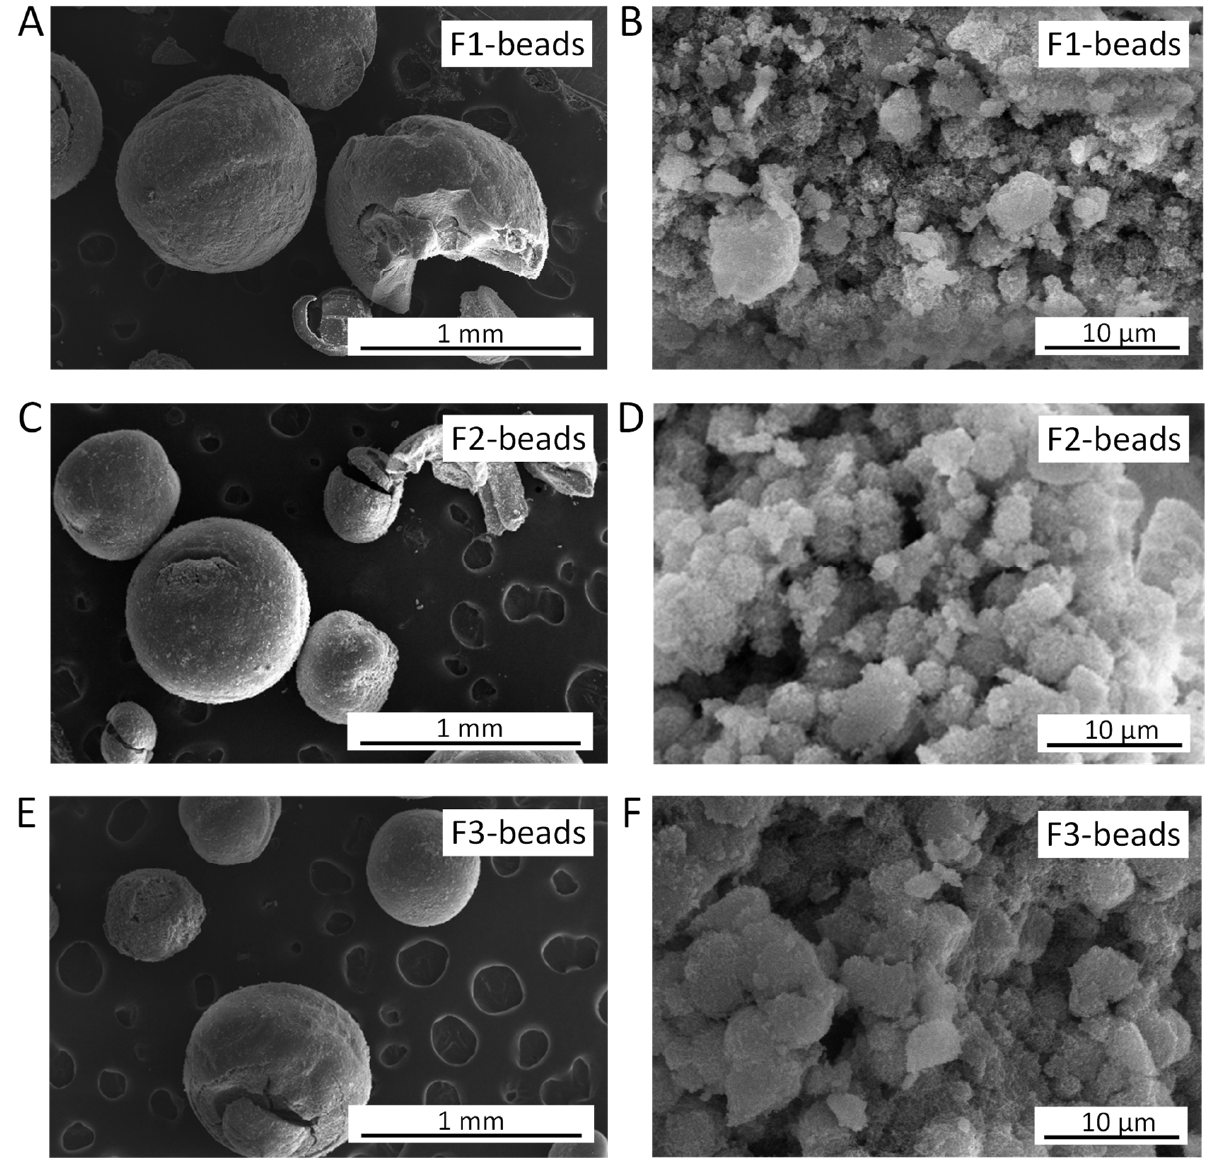
Figure 2. SEM images of: ( A ) F1-beads and ( B ) their interior; ( C ) F2-beads and ( D ) their interior; ( E ) F3-beads and ( F ) their interior.